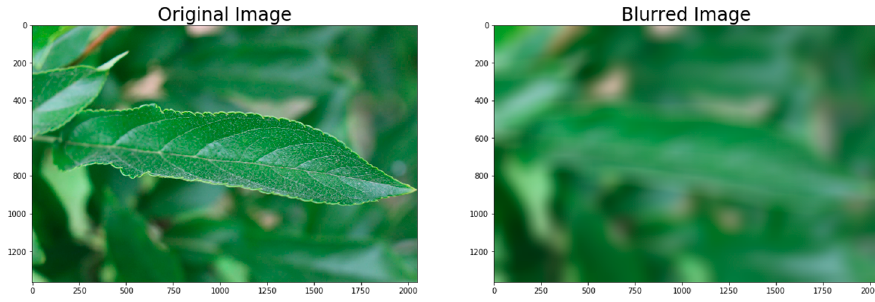
Figure 14. Output of Blurring.